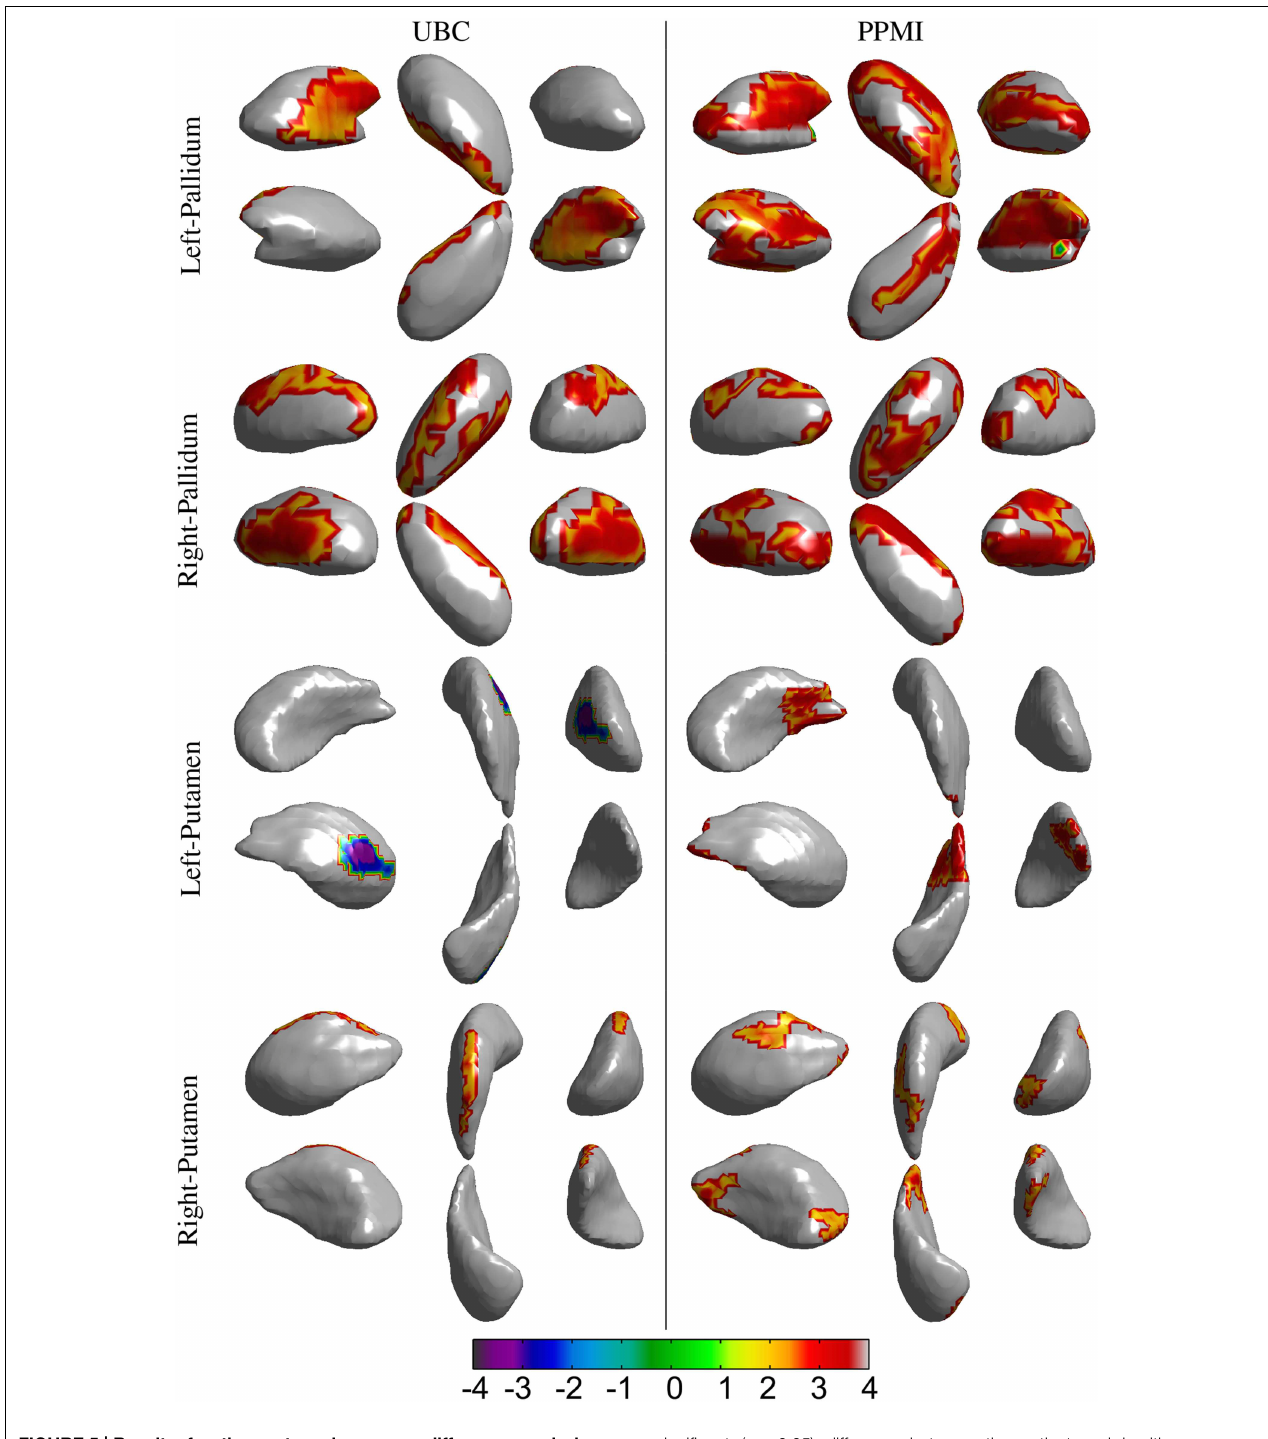
significant ( p < 0 . 05 ) difference between the patient and healthy control group. Gray colored area had no statistically significant difference between the groups. Positive t -value represents lower value in the patient